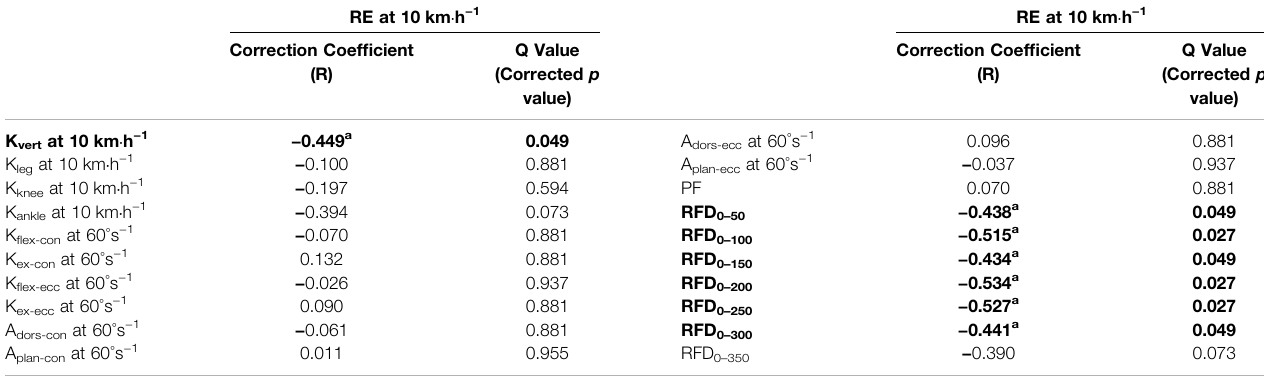
TABLE 2 | Correlations between neuromuscular characteristics and RE at 10 km · h − 1 ( n =